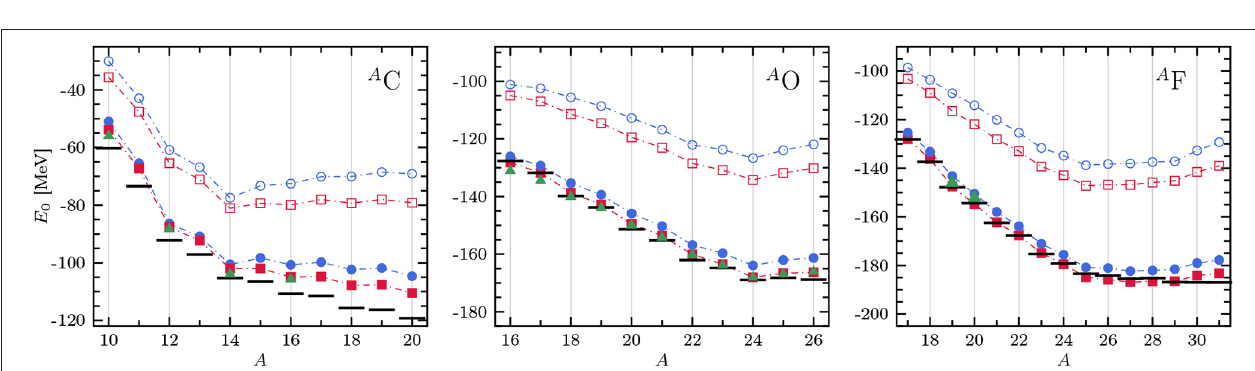
◦ FIGURE 7 | Reference ( / (cid:3) ) and second-order NCSM-PT ( l / (cid:4) ) energies with N ref max = 0 and 2, respectively, for the ground states of 11 − 20 C, 16 − 26 O, and 17 − 31 F using the Hamiltonian described in section 3. All calculations are performed using 13 oscillator shells and an oscillator frequency of ¯ h ω = 20MeV. The SRG parameter is set to α = 0.08fm 4 . Importance-truncated NCSM calculations ( H ) are shown for comparison. Experimental values are indicated by black bars. Reproduced from Tichai et al. [36] under the Creative Commons CC-BY license.